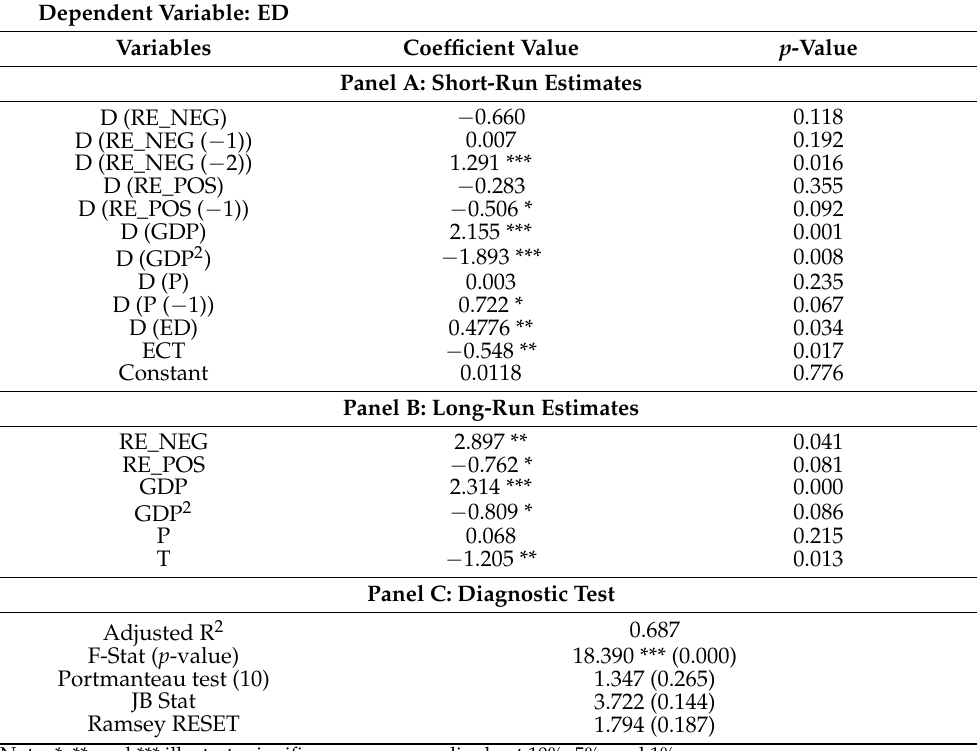
Table 5. The Short-run and Long-run Estimates of the NARDL